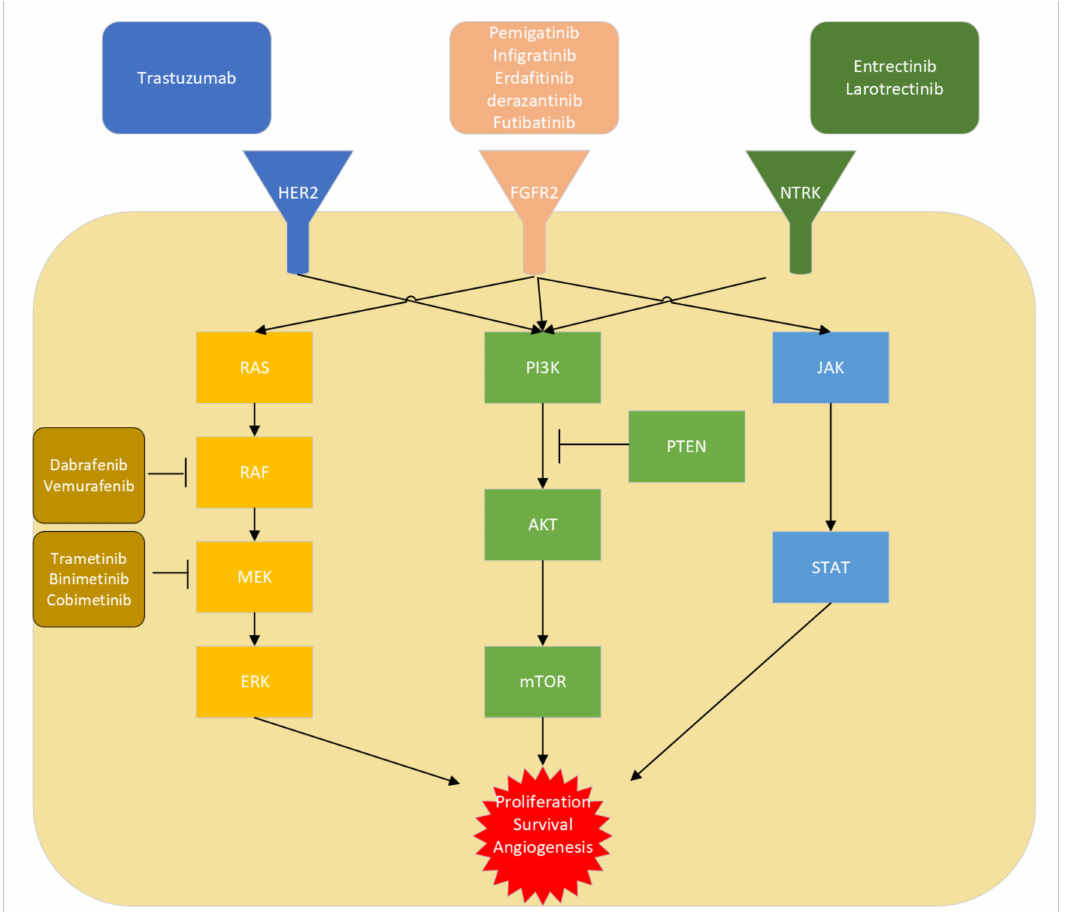
Figure 3. Molecular pathways in iCCA. Inhibitors have been developed for well-known signaling pathways including the Raf/MEK/ERK, PI3K-AKT, and JAK/STAT pathway. AKT: protein kinase B; FGFR: fibroblast growth factor; HER2: epidermal growth factor receptor 2; JAK: janus kinase; mTOR: mammalian target of rapamycin; PI3K: phosphoinositide 3-kinase. NTRK: neurotrophic receptor tyrosine